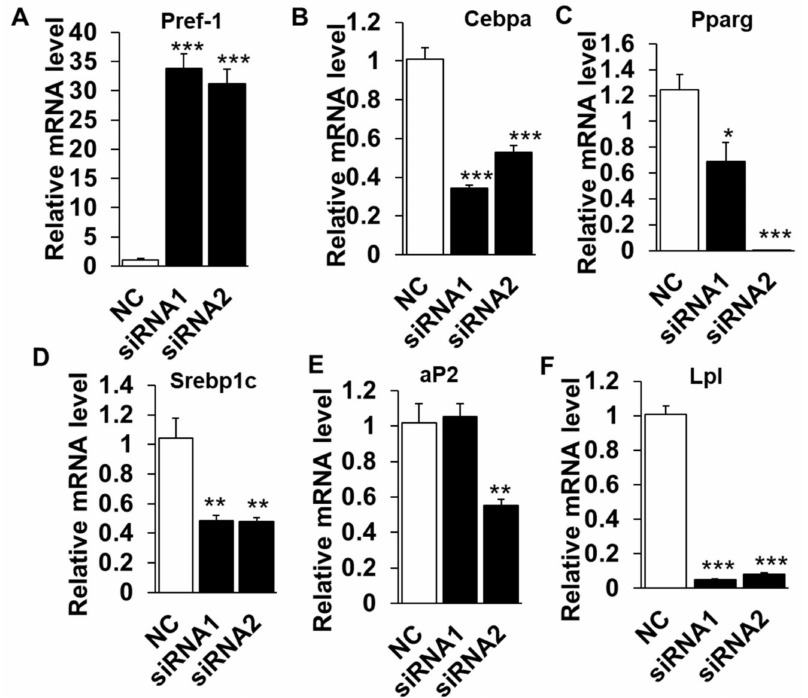
Figure 3. Knockdown of LXR α upregulates negative- and downregulates positive-intramuscular adipogenic genes. The mRNA levels between control and siRNAs treatment intramuscular adipocyte cells ( n = 6) of: Pref-1 ( A ); Cebp α ( B ); Pparg ( C ); Srebp1c ( D ); aP2 ( E ); and Lpl ( F ). * p < 0.05, ** p < 0.01, *** p < 0.001, compared to that of negative control (NC). Data are shown as the means ± SEM.